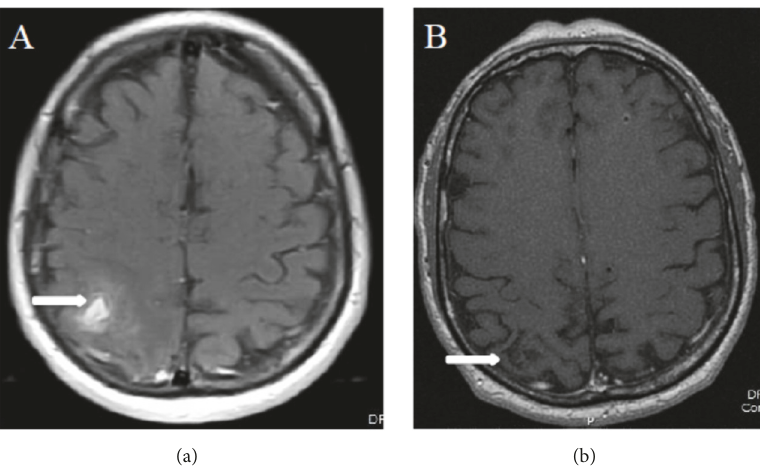
Figure 1: MRI brain . (a) An axial, postcontrast-enhanced, fat-saturated T1-weighted image of the brain shows a 2.0 x 1.0 cm right parietal mass with ill-defined area of enhancement. (b) An axial, contrast enhanced, fat-saturated T1-weighted image of the brain, 3 weeks after therapy with cabozantinib, shows resolution of the prior mass and surrounding enhancement.